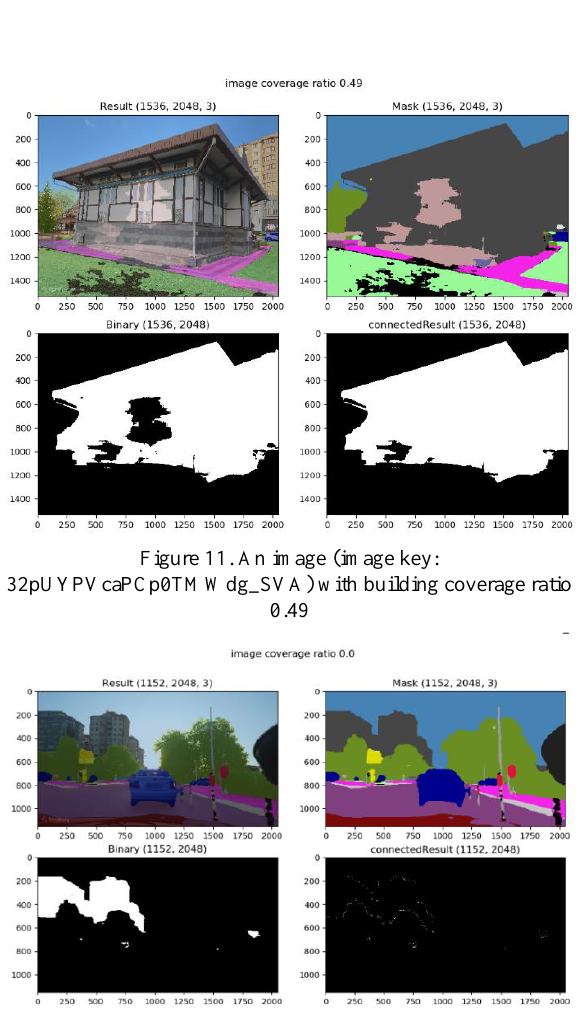
Figure 12. An image (image key: 2FZgFFC3jVJnxolqrdUv-Q), the relative target location was detected as right, provides only pixels on the right side of the image on coverage ratio calculation, thus results coverage ratio 0.0